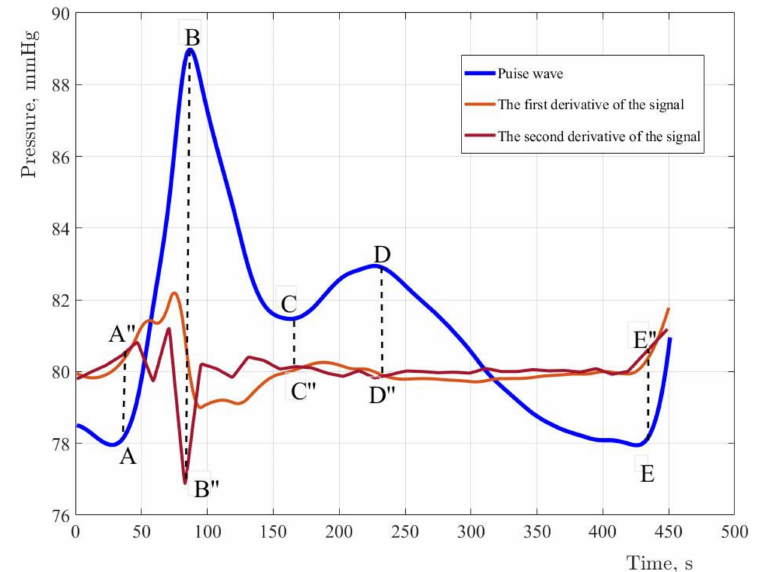
Figure 8. The original signal and derivatives of the first and second order with normalized values and coefficients. For the first derivative, the coefficient is assumed to be equal to five. For the second derivative, the coefficient is fifty. The coefficient determines the steepness of the amplitudes of the